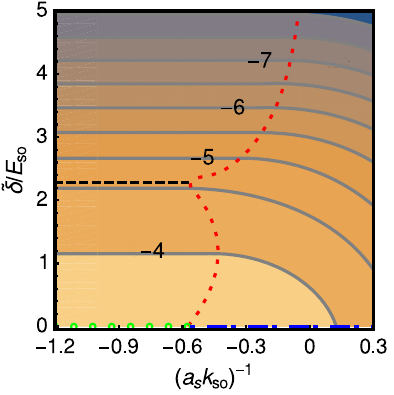
FIG. 7. Lowest relative three-boson scattering threshold for Ω =E ¼ 2 . The contours show the energy E , in units of E , of so th so the lowest three-boson scattering threshold as functions of ð a Þ − 1 and ˜ δ =E k . To the left of the thick dotted line, bound s so so dimers are not supported and the lowest threshold is given by E aaa . In this regime, the lowest scattering threshold is independent th Þ − 1 . To the right of the thick dotted line, a weakly bound k of ð a s so bosonic dimer exists and the lowest threshold is given by E ad . In th Þ − 1 . k this regime, the lowest scattering threshold depends on ð a s so The thick open circles and thick dashed line mark the ½ð a Þ − 1 ; ˜ δ =E (cid:4) combinations for which the lowest three-atom k s so so threshold has a degeneracy of six and four, respectively. The thick Þ − 1 ; ˜ δ =E (cid:4) combinations for k dash-dotted line marks the ½ð a s so so which the lowest atom-dimer threshold has a degeneracy of two. In the region encircled by the thick open circles, the thick dotted line, the thick dashed line, and the left edge of the figure, the degeneracy of the three-atom threshold is equal to three. In the region encircled by the thick dashed line, the thick dotted line, the upper edge of the figure, and the left edge of the figure, the degeneracy of the three-atom threshold is equal to one. In the region encircled by the thick dash-dotted line, the right edge of the figure, the upper edge of the figure, and the thick dotted line, the degeneracy of the atom-dimer threshold is equal to one. The range of scattering lengths shown on the horizontal axis is, even though different units are used, the same as in Fig.